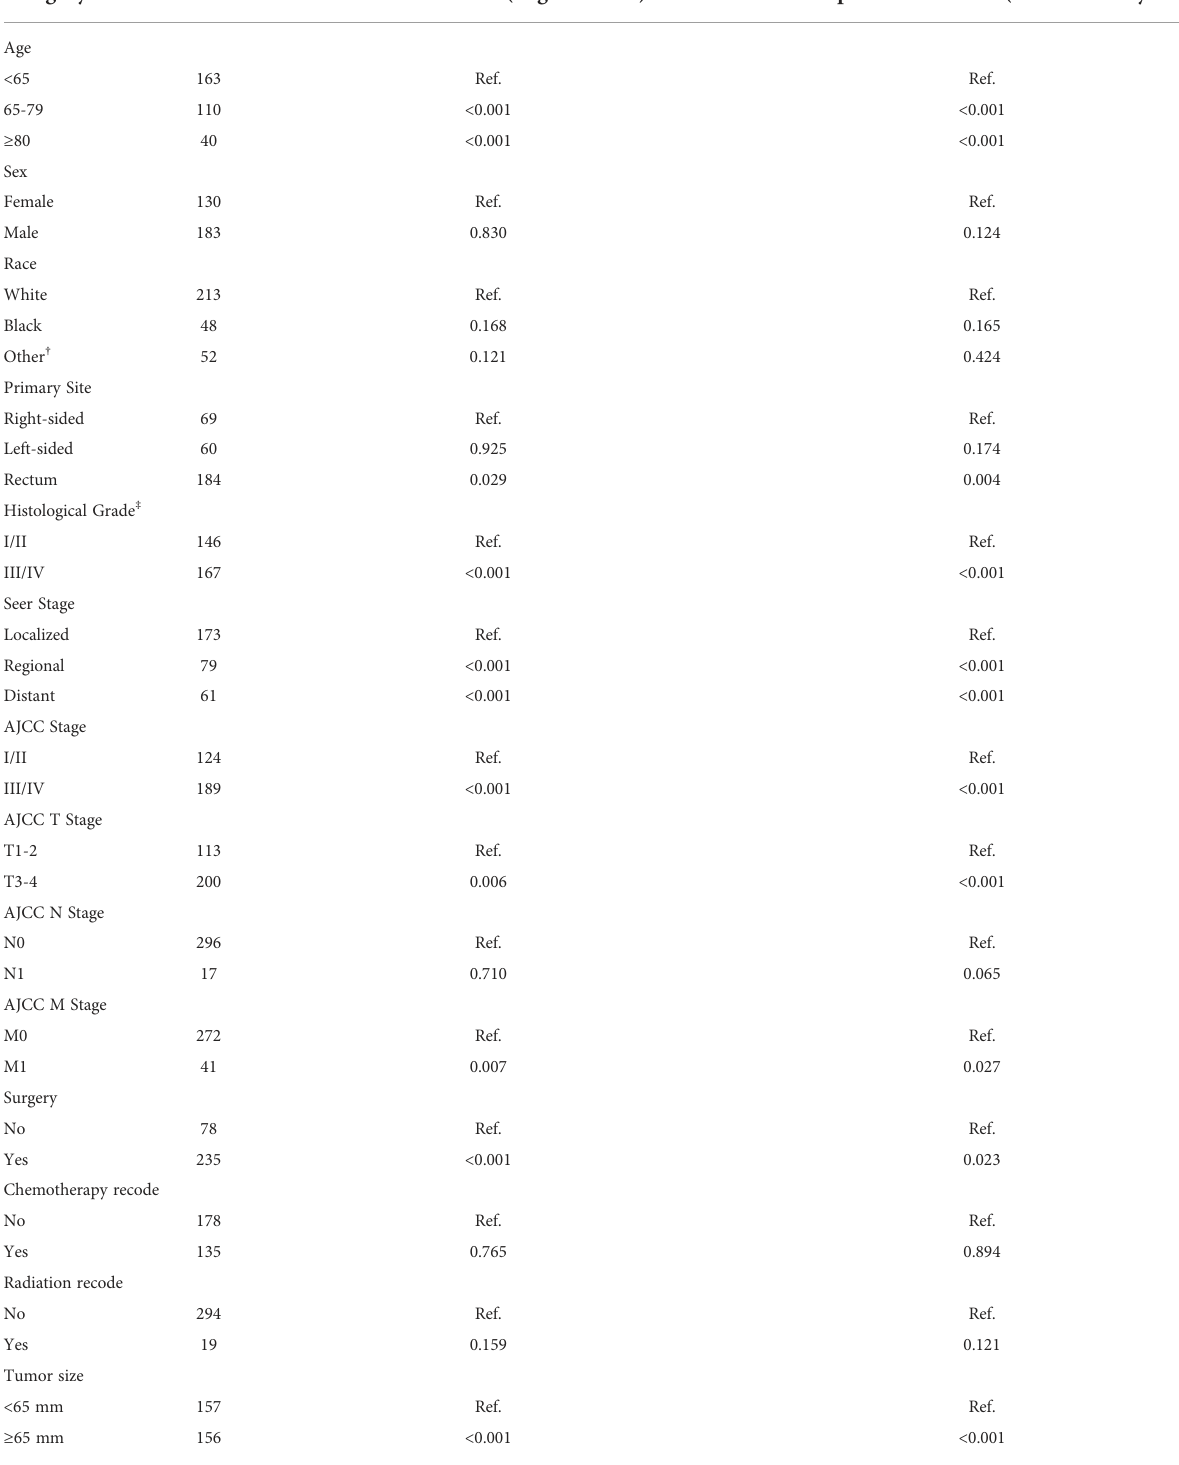
TABLE 2 Univariate analysis for Overall survival and Cancer-speci fi c survival in training cohort. Cetegory